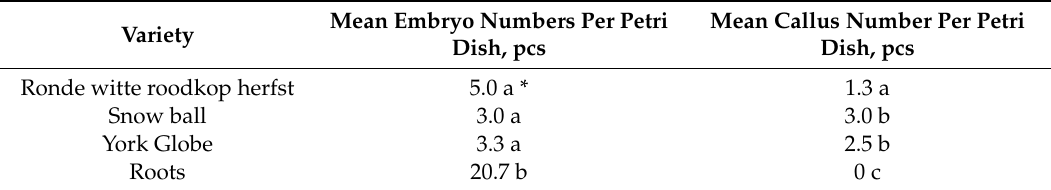
Table 1. Embryo and callus development in the microspore culture isolated from flower buds of di ff erent turnip